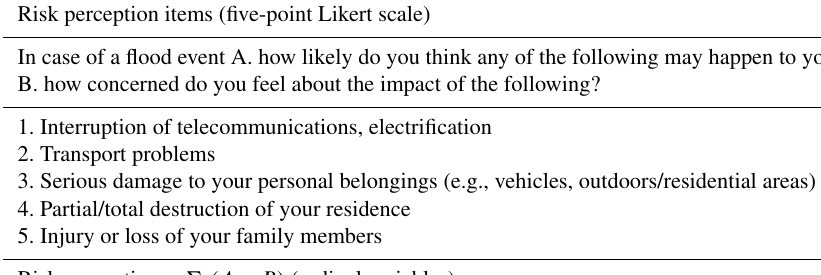
Table 5. Risk perception: items and model variable. Risk perception items (five-point Likert